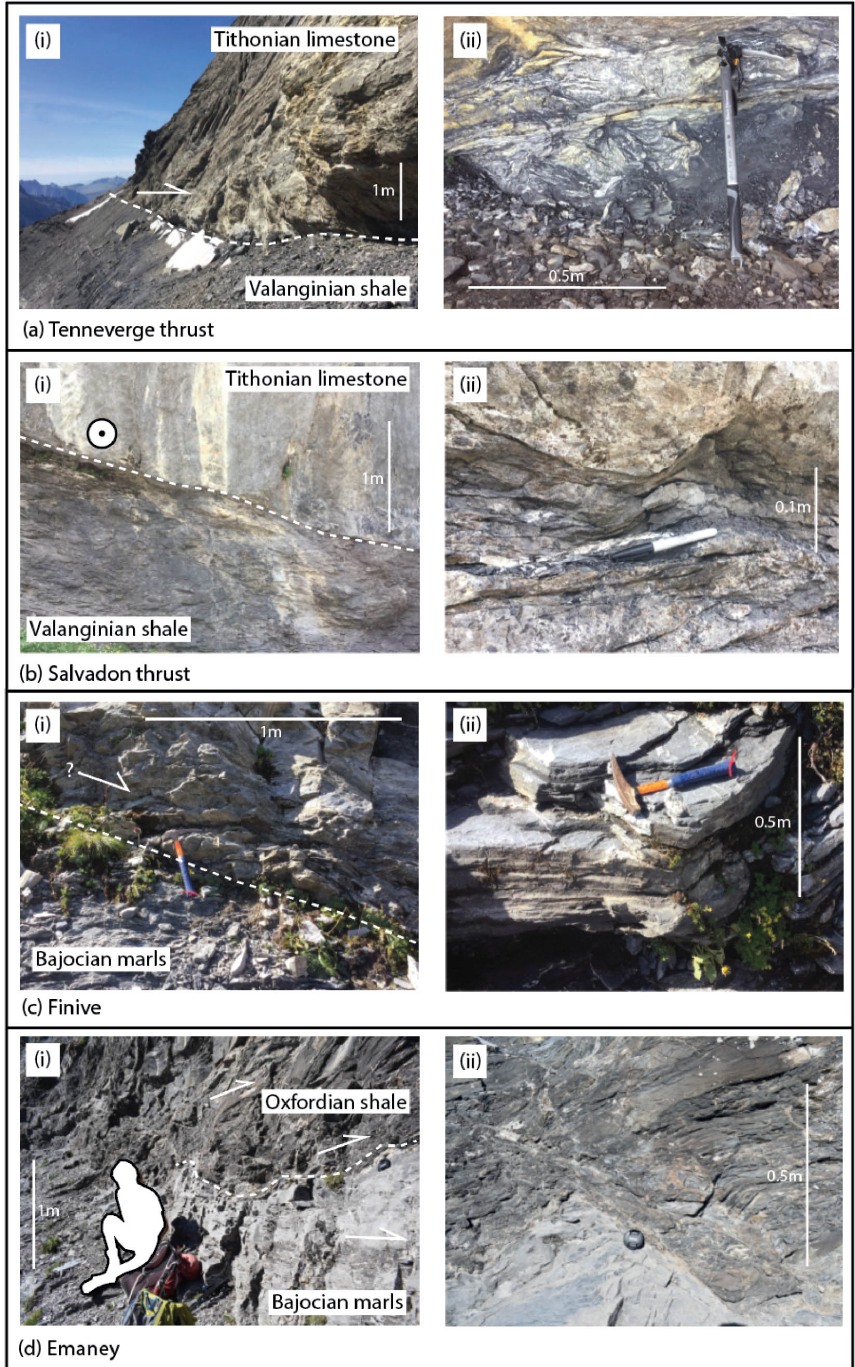
Figure 2. “Strained” localities. (a) Tenneverge thrust, showing (i) Tithonian limestone in the hanging wall thrusted at a low angle over Valanginian shale, and (ii) a close-up of the thrust surface, showing penetration of the fault zone into the footwall shales. (b) Salvadon thrust, showing (i) the thrust surface at outcrop scale, with Tithonian limestone thrust over Valanginian shales, and the direction of displacement obliquely out of the page; (ii) a close-up view of the thrust surface, showing a clear step change in lithology and small undulations in the surface. (c) Finive shear zone and thrust splay, with (i) the fault exhibiting displacement on a 1 to 10m scale, occupying the apparent geometry of a low-angle normal fault; (ii) ductile fabrics of the surrounding shear zone. (d) Emaney shear zone, demonstrating (i) the partitioning of strain into the overlying shales, evident in the differing fabric intensities; (ii) a close-up of the boundary between the two units.